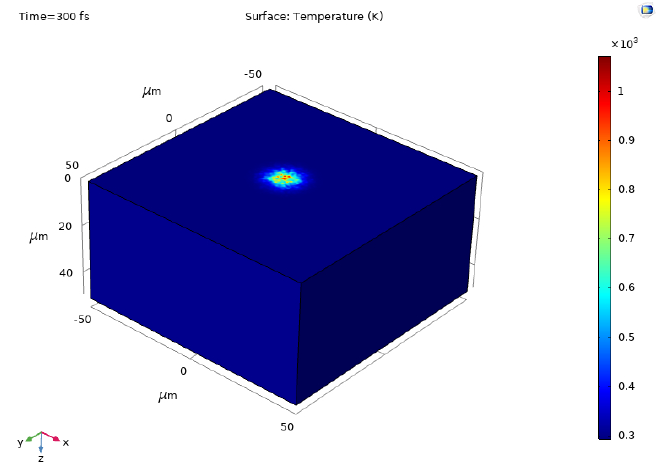
Figure 1. Surface temperature distribution in PDMS during laser ablation with threshold energy. Table 1. The values of simulation parameters for laser ablation threshold.